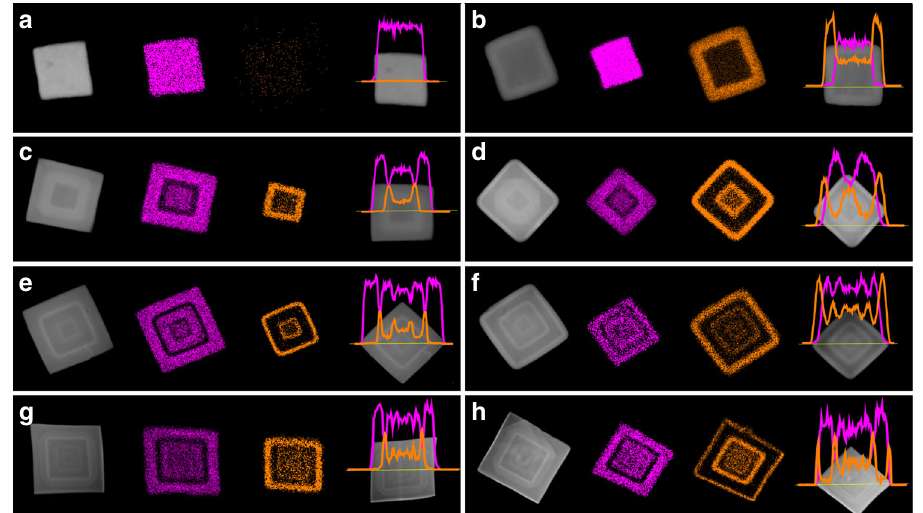
Fig. 3 EDX elemental mapping and line scanning of ZIF-67 and nano-Matryoshka structured ZIFs. a ZIF-67, b ZIF-67@ZIF-8, c tri-layered ZIF, d tetra- layered ZIF, e penta-layered ZIF, f hexa-layered ZIF, g hepta-layered ZIF and h octa-layered ZIF. Colour code: purple represents cobalt; brown represents